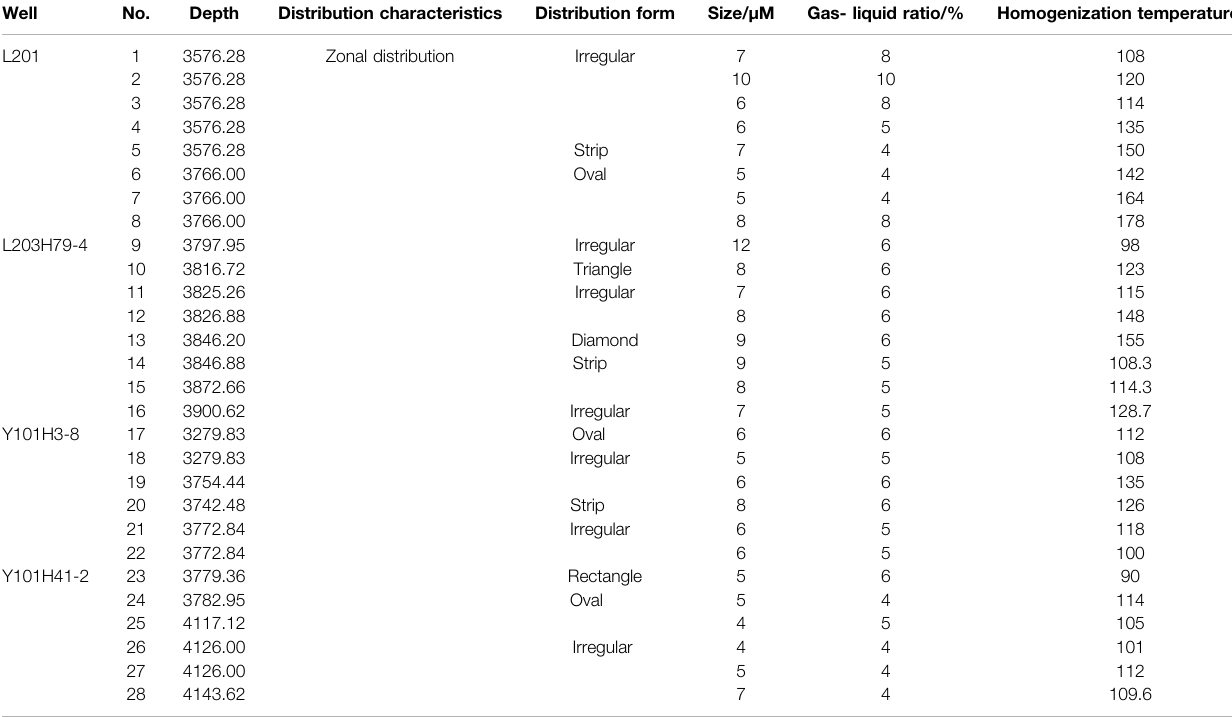
TABLE 1 | Test data of fl uid inclusions in fracture fi llings of the Longmaxi Formation (partial). Well No. Depth Distribution characteristics Distribution form